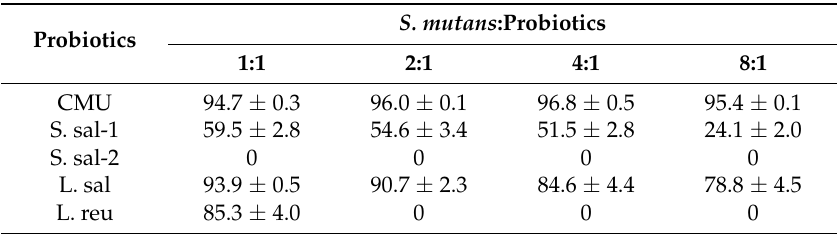
Table 2. Dose-dependent effects of oral probiotic strains on the formation of S. mutans biofilms expressed as inhibition level (%).